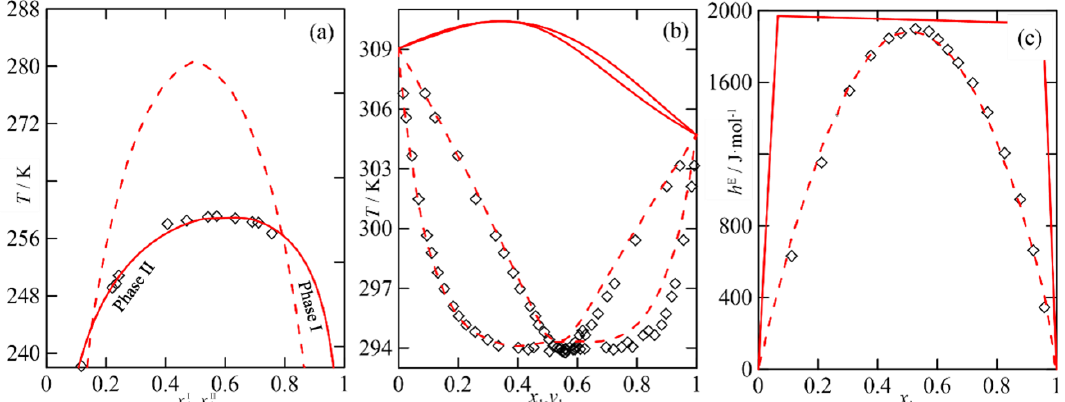
Figure 5. Plot of the estimations obtained for ( a ) T vs x I , or x II (LLE), ( b ) T va x 1 , or y 1 (VLE), ( c ) h E vs x 1 , using two parametrizations of the NRTL model for the binary methyl methanoate (1) + pentane (2). ( – – ) ref [25]; ( — ) APV88. , experimental data. Table 2. Parametrization of NRTL using parameters from literature *, obtained using the multi- property approach for the binary methyl methanoate (1) + pentane (2).